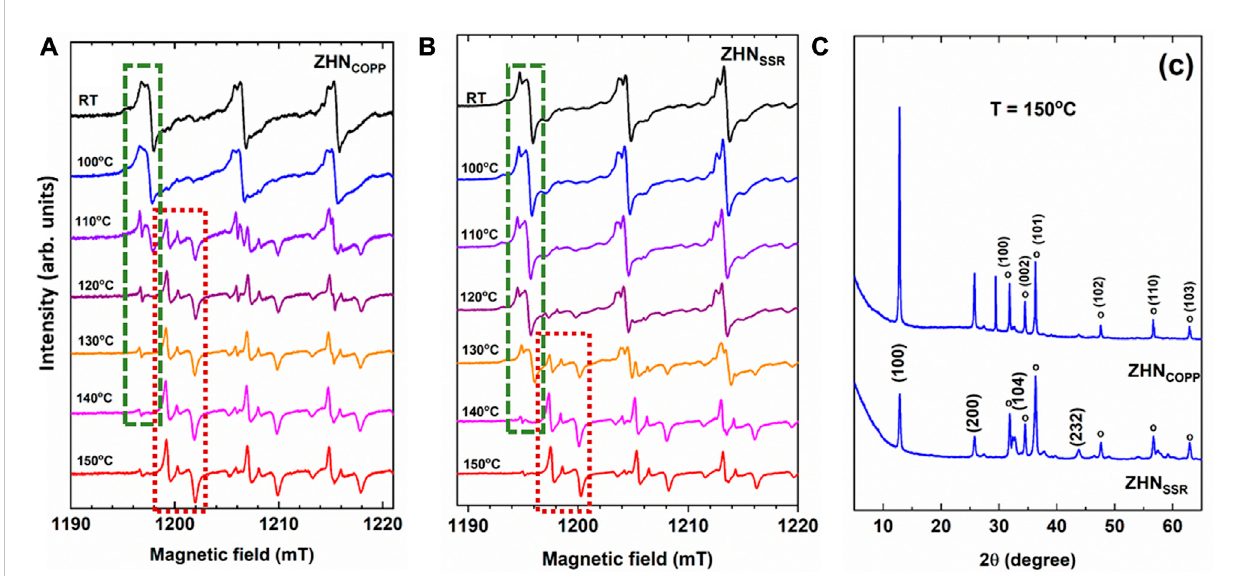
FIGURE 6 DetailedviewoftheEPRspectraoftheMn 2+ ionsintheZHN COPP (A) ,andZHN SSR (B) samples,as-prepared(RT)andisochronallyannealed(10 minat each indicated temperature). Only the fi rst three hyper fi ne transitions at low- fi eld are displayed for simplicity. Transformation of the Mn 2+ centers in the zinc hydroxynitrate phases into Mn 2+ centers in ZnO is evidenced with green and dark red dotted lines, respectively, only for the fi rst hyper fi ne transition, where these centers do not overlap. (C) XRD patterns of both samples after isochronal annealing up to 150 ° C. The ZnO phase is marked with open circles and indexed in the upper pattern, while the Zn 3 (OH) 4 (NO 3 ) 2 phase is indexed in the lower